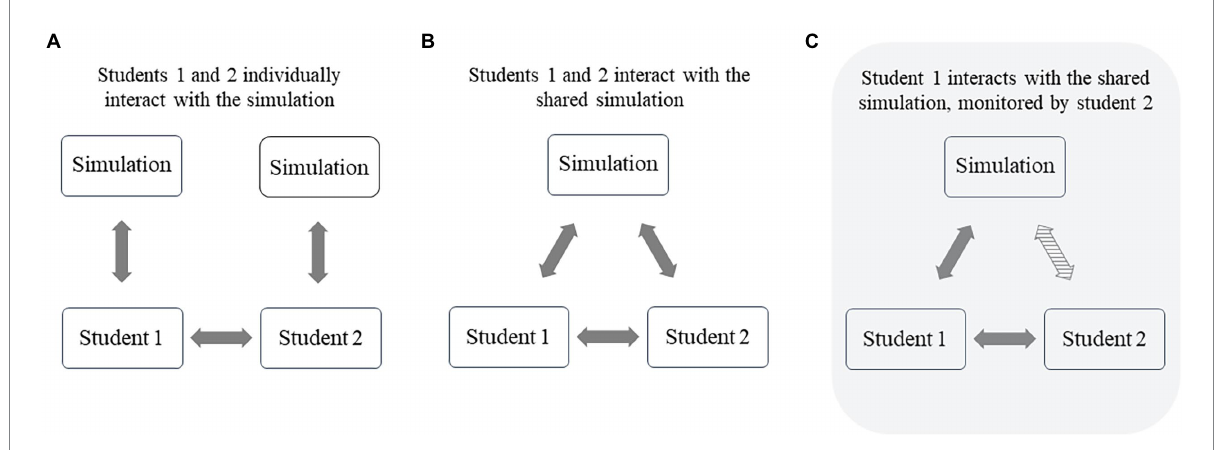
FIGURE 1 The interactions (double-sided arrows) among the students and simulation with the (A) individual-based simulations, (B) collaborative simulations, and (C) individual-based simulations used with the screen-sharing functionality in computer-mediated collaborative knowledge construction. The current study focuses on the faded scenario (C) , in which student 1 is sharing and student 2 is monitoring the